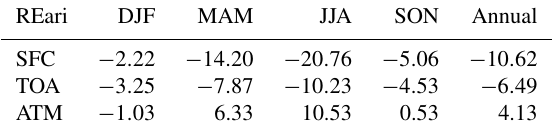
Table 10. Annual and seasonal mean of the REari over Germany (47 to 55 ◦ N and 6 to 15 ◦ E) quantified by T–CARS.